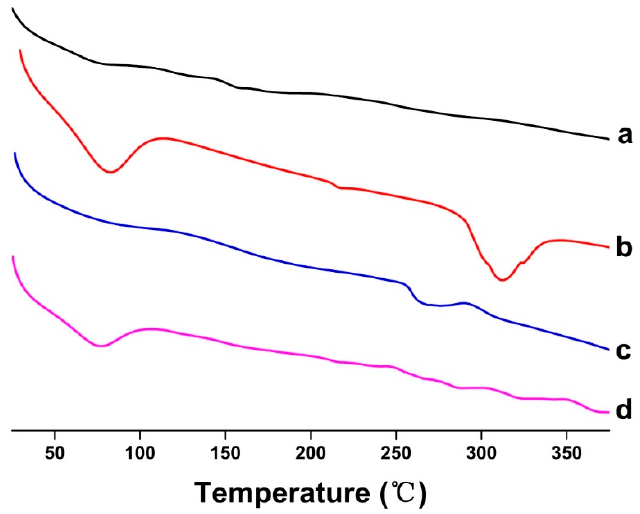
Figure 6. DSC thermograms of ( a ) Forsythia suspensa leaf extract (FSE), ( b ) β -CD, ( c ) β -CD-assisted extract of Forsythia suspensa leaves (FSE- β -CD) and ( d ) β -CD with Forsythia suspensa leaf extract 1:1 physical mixture (FSE/ β -CD PM).